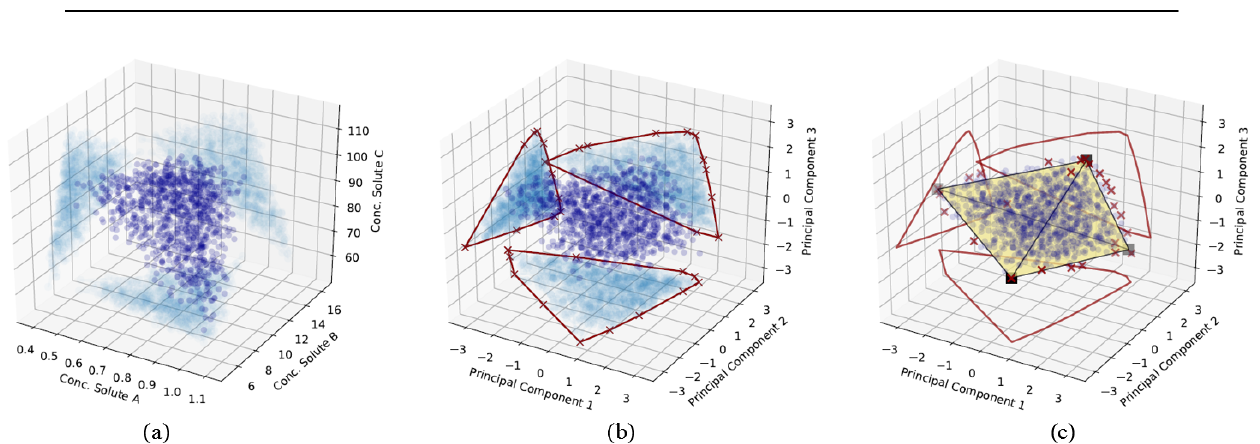
Figure 1. Illustration of the CH-NMF algorithm using a three-dimensional space with four end-members. (a) The standardized observations (dark blue) and its projection (light blue) on the observational space. (b) The projected observations (dark blue) and its projection (light blue) on PC subspaces. The red crosses are the marked extreme points ( S ) that form a convex hull (the red polygons) in each PC subspace. (c) Find the convex hull (the black simplex) and its associated vertices (the k vectors x emi ) in the PC space, such that the vertices are convex combinations of the extreme points S , and the distance between the simplex and S is minimized. The red crosses are the same extreme points marked in (b) but are projected back in the three-dimensional PC